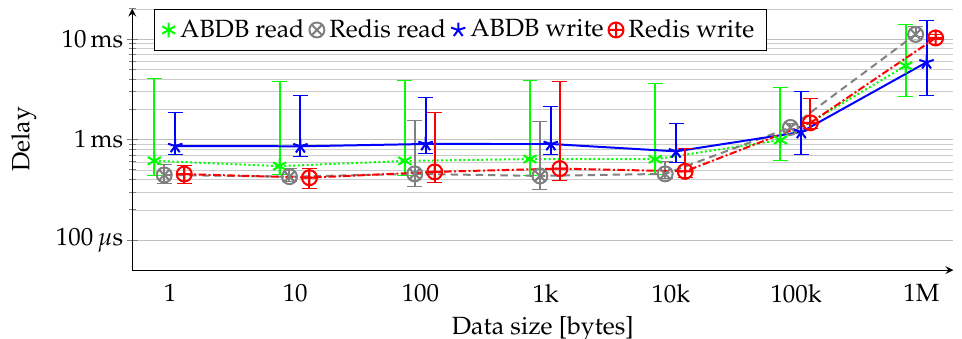
Figure 7. Data access latency of functions deployed to an edge node where only an ABDB child is available. Redis can be accessed on a separate node with a delay of approximately 0.155ms. Maximum, average and minimum values are